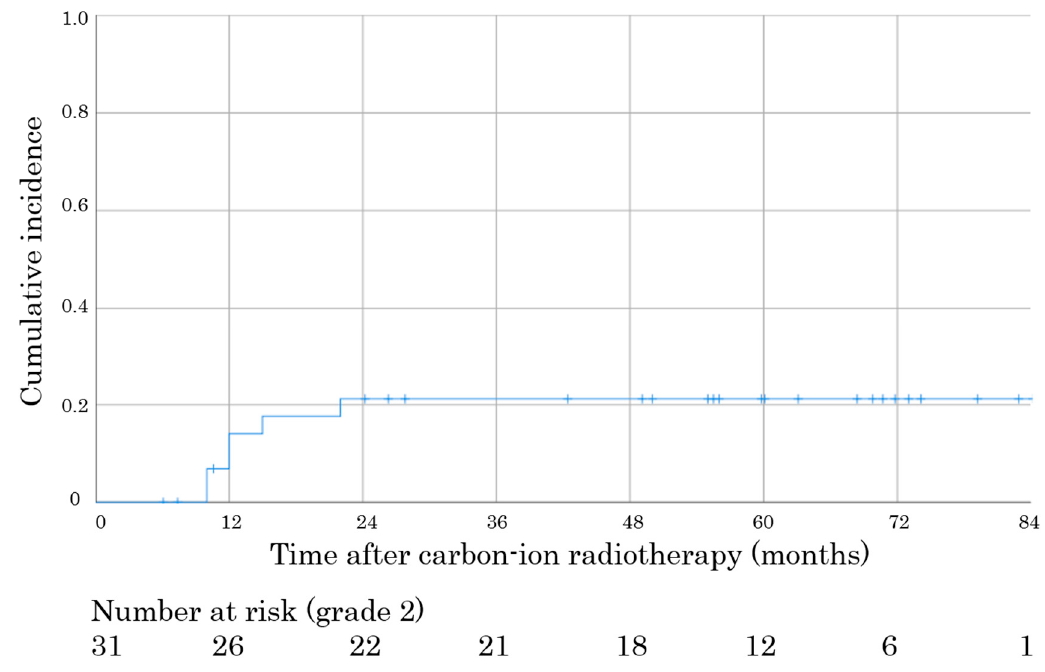
Figure 1. Cumulative incidence of grade 2 carbon ion radiotherapy-induced trismus after carbon ion radiotherapy in patients with this study (n =